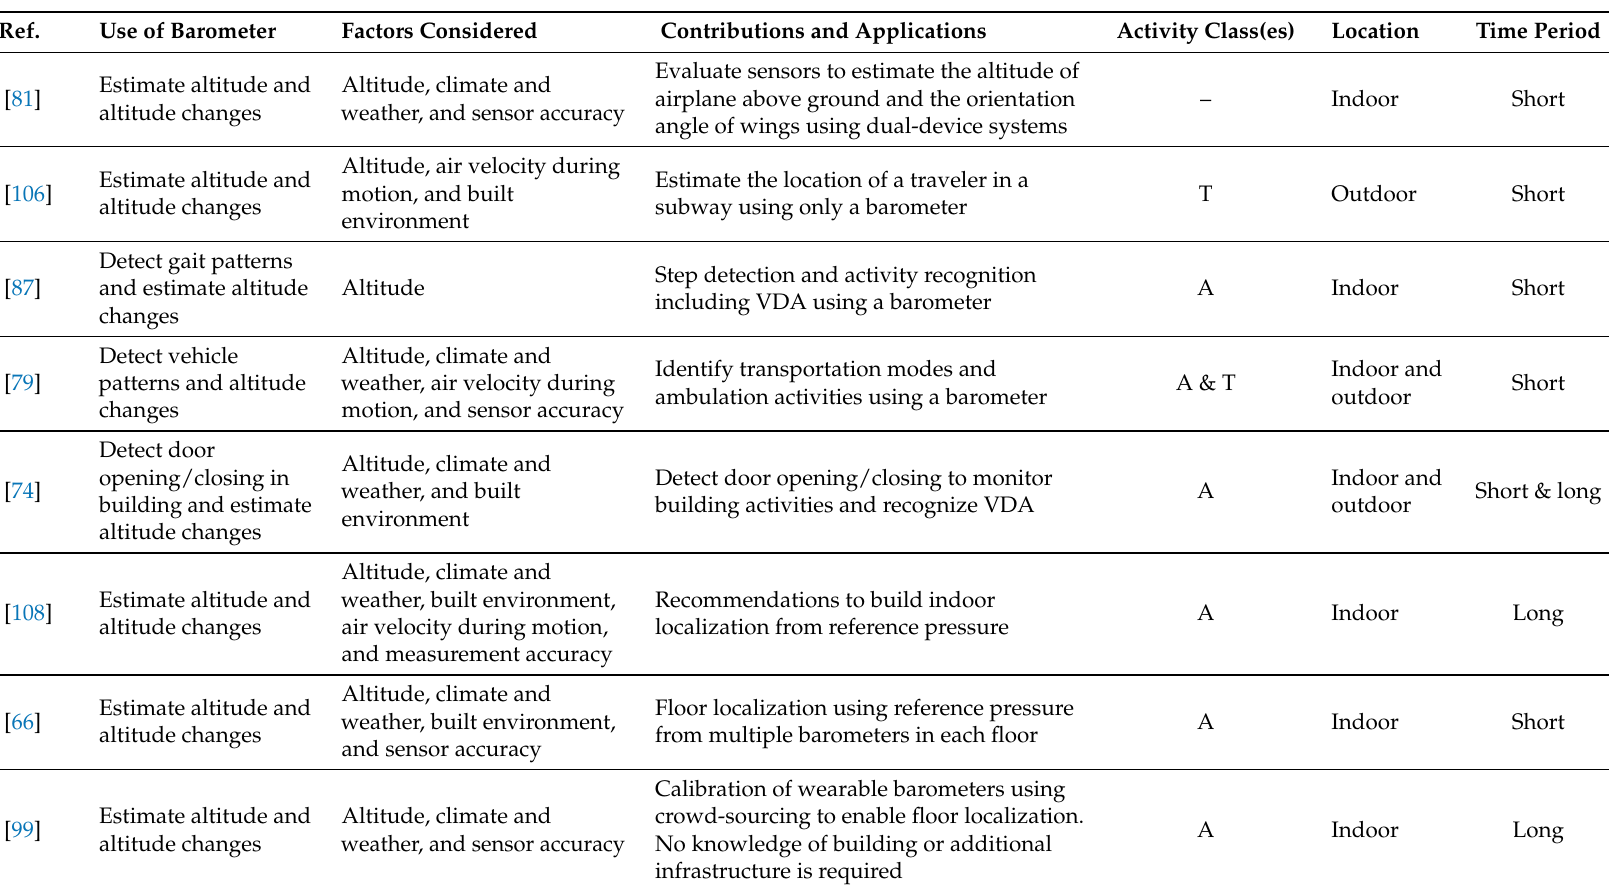
Table 1. Categorized literature related to the application or use of barometers for human activity recognition. Two types of activity classes: (A) ambulation and (T)